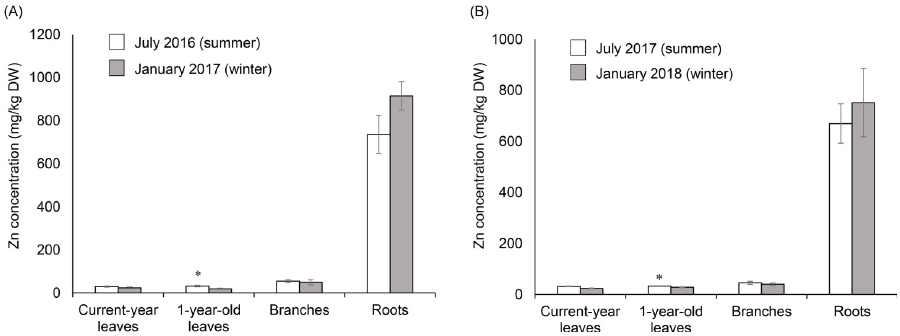
Fig 1. Zn concentrations in A . japonica . (A) Zn concentrations in A . japonica in July 2016 and January 2017, and (B) Zn concentrations in A . japonica in July 2017 and January 2018. Zn concentrations are expressed as means ± standard error (current-year and 1-year-old leaves in July 2016 and January 2017, n = 6; other parts, n = 10). Differences were evaluated by Wilcoxon signed-rank test: � , P < 0.05. https://doi.org/10.1371/journal.pone.0257690.g001 showed seasonal variations; the concentrations in 1-year-old leaves were significantly higher in July 2016 (summer) than in January 2017 (winter) ( P = 0.028), and higher in July 2017 (summer) than in January 2018 (winter) ( P = 0.047) (Fig 1). Mn also showed seasonal varia- tions; the concentration in current-year leaves was significantly higher in January 2017 (win- ter) than in July 2016 (summer) ( P = 0.046) and higher in January 2018 (winter) than in July 2017 ( P = 0.022), and the concentration in 1-year-old leaves was significantly higher in July 2017 than in January 2018 ( P = 0.007) (S2 Table). Copper exhibited seasonal variations; the concentrations in current-year leaves were higher in January 2017 (winter) than in July 2016 (summer) ( P = 0.028), and the concentration in branches was higher in July 2017 (summer) than in January 2018 (winter) ( P = 0.022).